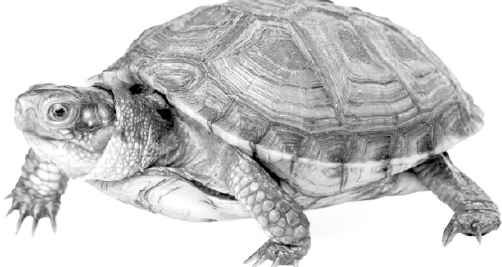
Figure 8. Pond turtle (Family Emydidae: Terrapenecarolina ), showing sprawling gait typical of amphibious turtles.